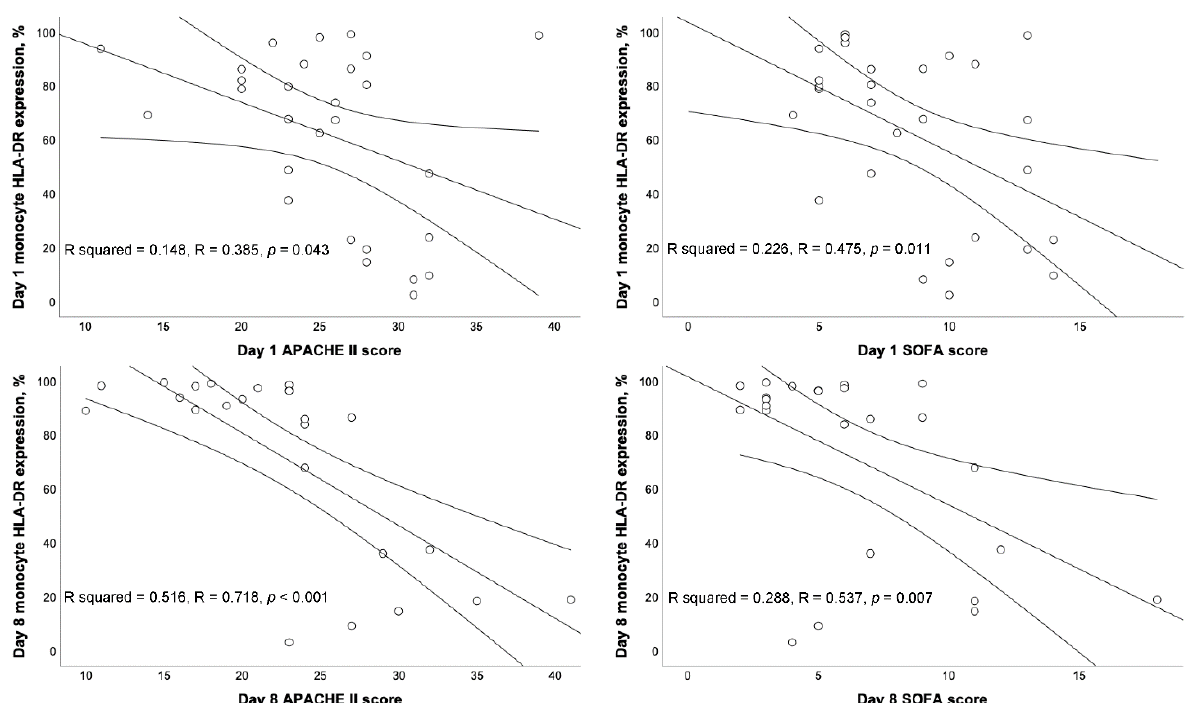
Figure 3. Scatterplots showing the correlation with linear regression lines (mean and 95% confidence interval) between monocyte human leukocyte antigen (HLA)-DR expression and Acute Physiology and Chronic Health Evaluation (APACHE) II score and Sequential organ failure assessment (SOFA) score on days 1 and 8. Pearson correlation coefficient (R) and the coefficient of determination (R squared) were calculated.